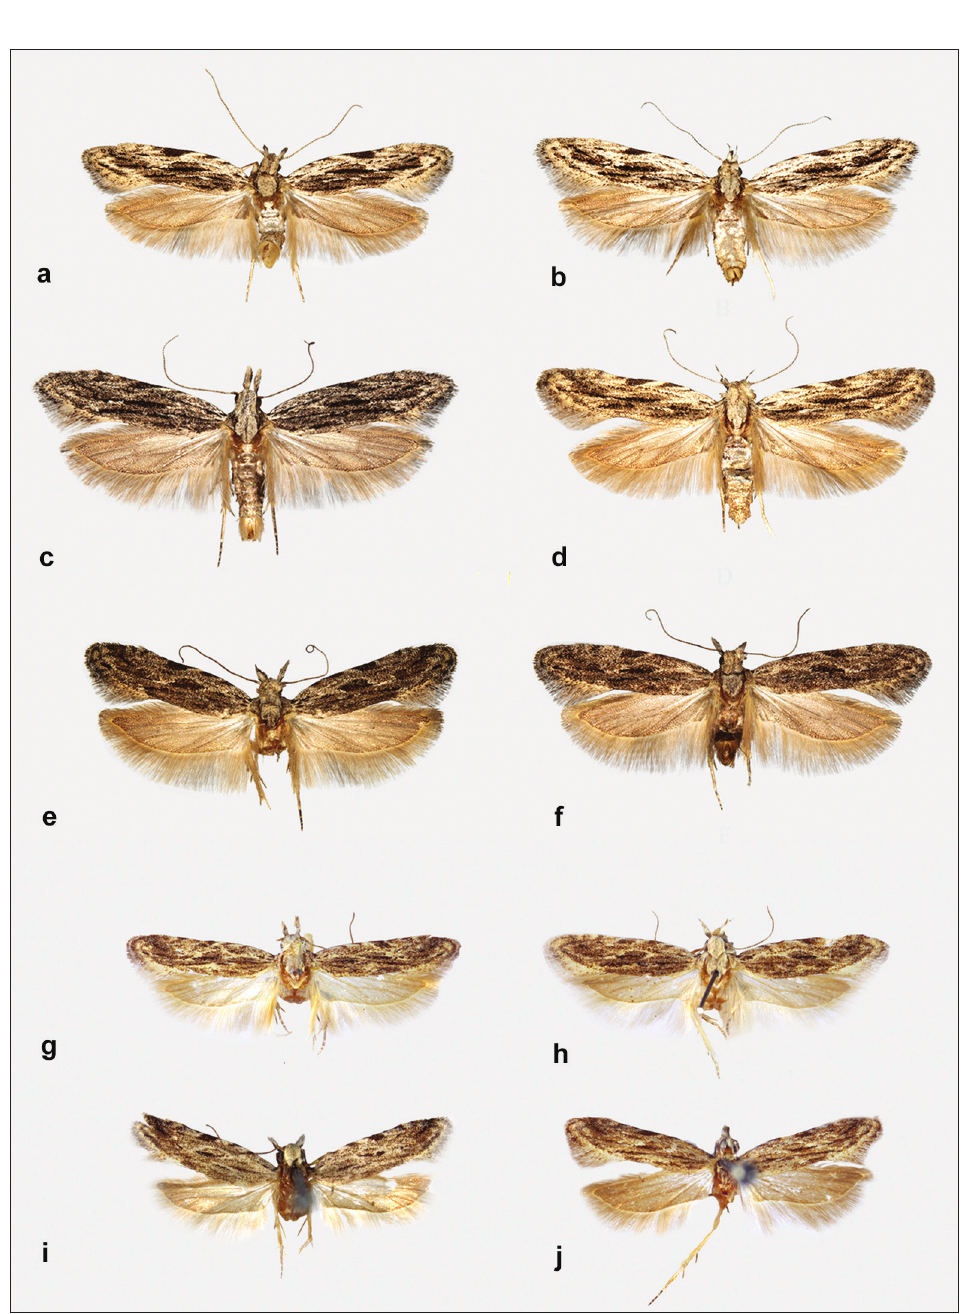
Figure 5. Anarsia adults. a. A. innoxiella sp. n., Denmark (KG); b. A. innoxiella sp. n., Holotype, Denmark (ZMUC); c. A. innoxiella sp. n., Latvia (ECKU); d. A. innoxiella sp. n., Germany (ECKU); e. A. lineatella Zeller, Germany (KG); f. A. lineatella Zeller, Germany (ECKU); g. A. lineatella ssp. heratella Amsel, Afghanistan (SMNK); h. A. lineatella ssp. heratella Amsel, Afghanistan (SMNK); i. A. lineatella ssp. tauricella Amsel, holotype, Turkey (ZSM); j. A. lineatella ssp. tauricella Amsel, paratype, Turkey